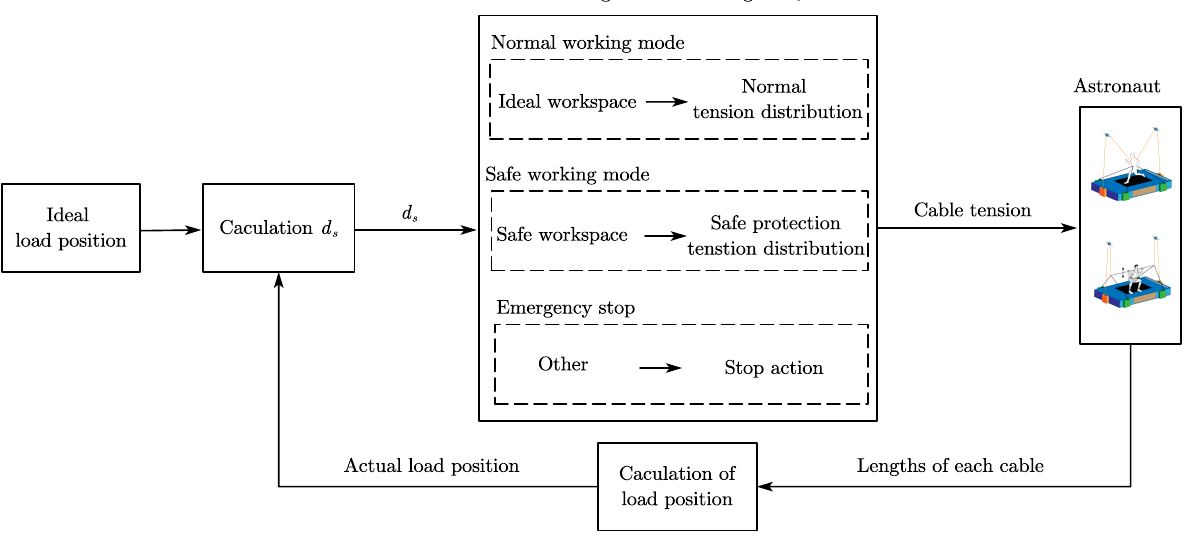
Figure 8. Safety protection strategy block diagram of